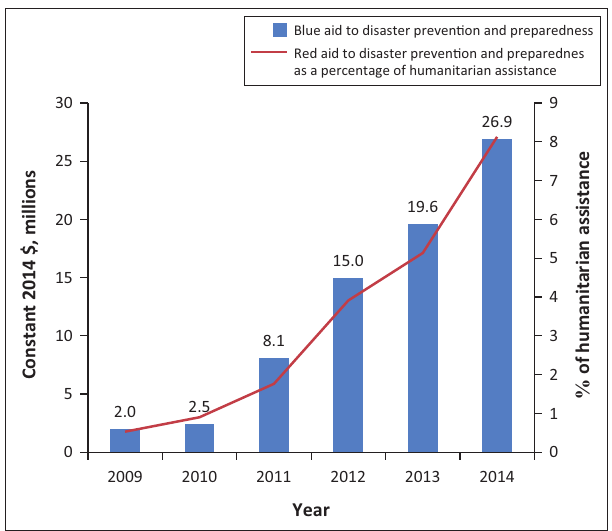
FIGURE 2: Donor funding to disaster prevention and preparedness between 2009 and 2014.